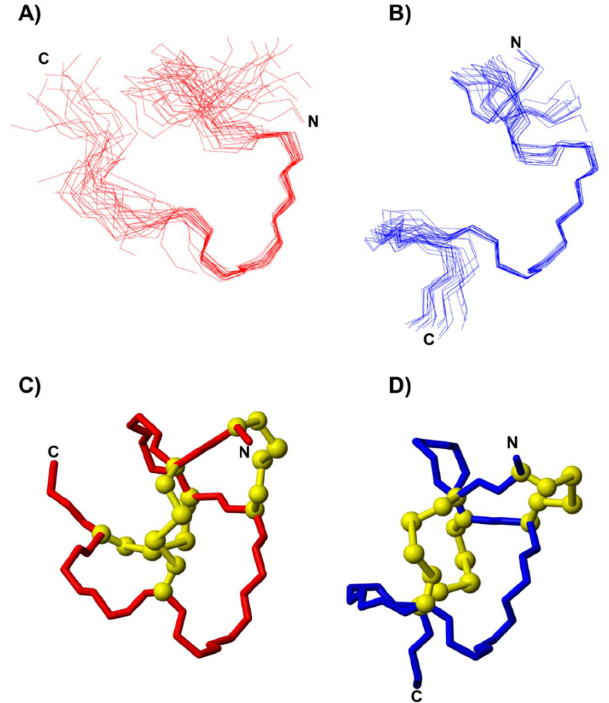
Figure 3. Three-dimensional structures of MC12-linaclotide. A superposition of the 20 lowest energy structures of MC12-linaclotide determined in ( A ) aqueous solution and ( B ) 100 mM SDS. ( C ) The lowest energy structure of MC12-linaclotide in ( C ) aqueous solution and ( D ) 100 mM SDS, with the disulfide bonds shown in ball-and-stick format. The figure was generated using MOLMOL